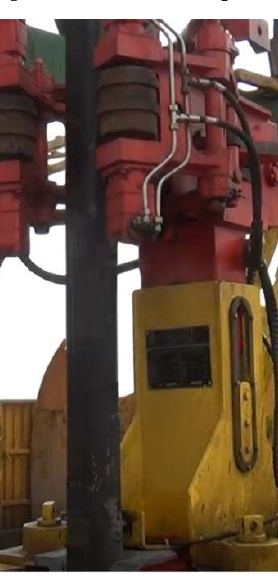
Figure 10. Experiment involving the spinner mechanism with single follow-up roller.